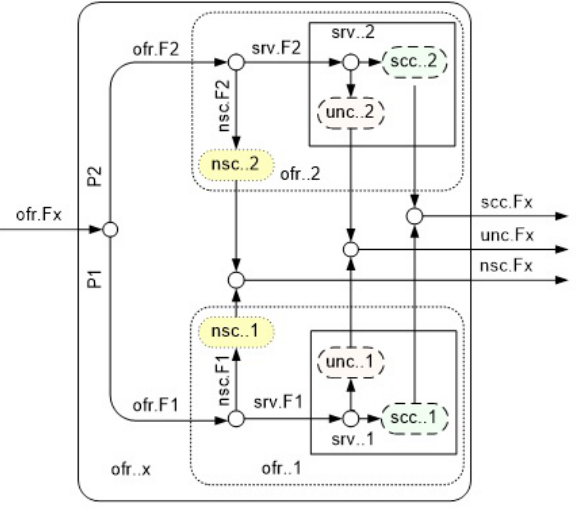
Figure 6. Parallel composition of two services (see